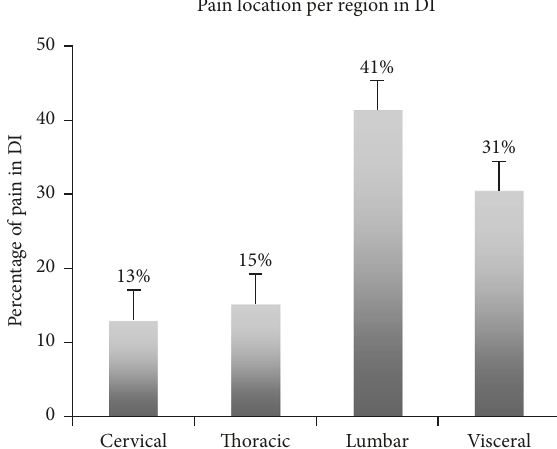
Figure 5: Pain location noted in percentage per region during a 3-day dry immersion (DI). Pain location in DI in percentage of apparition per region (% on 46